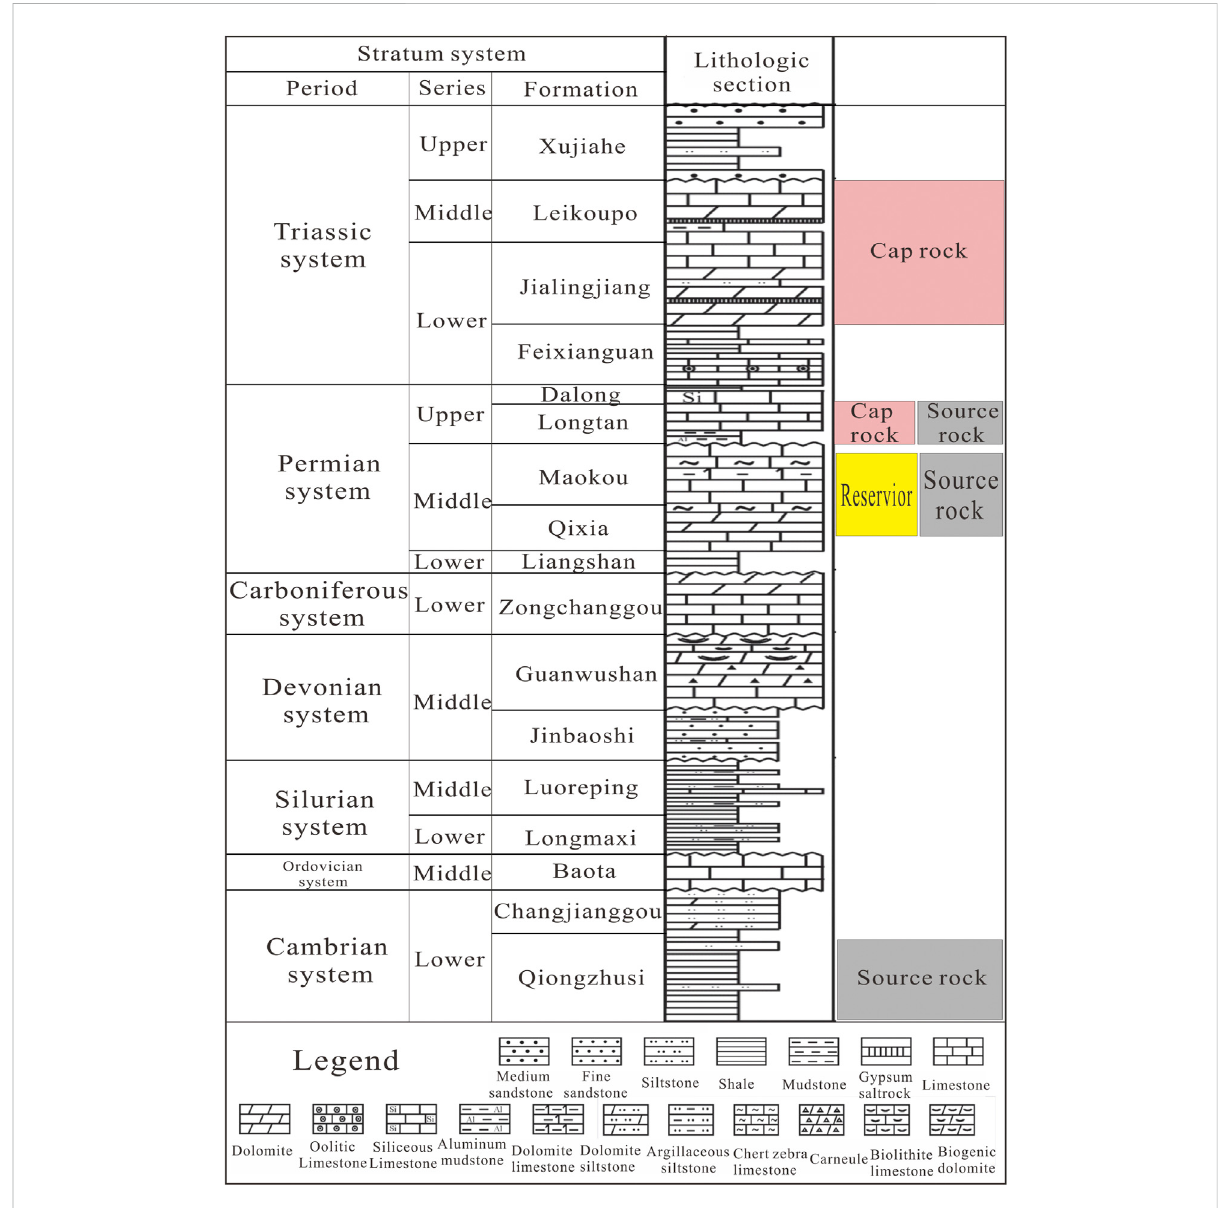
FIGURE 2 A generalized stratigraphic column of the Northwestern Sichuan